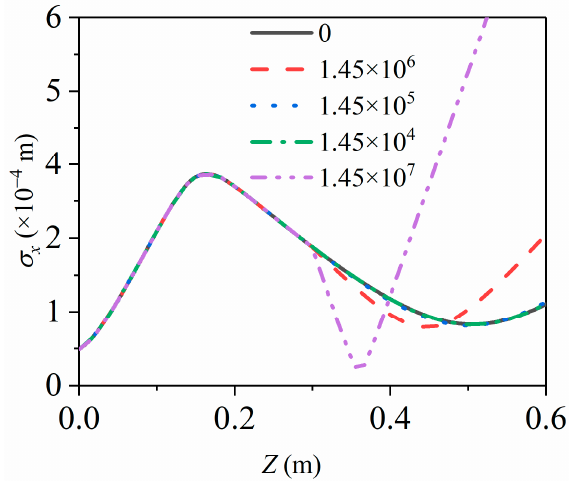
Figure 6. RMS radius σ x evolves during propagation at various longitudinal compression strengths, while the solid black line is 0, the red dashed line is 1.45 × 10 6 V/m, the blue dot is 1.45 × 10 5 V/m, the green dashed line is 1.45 × 10 4 V/m and the purple double-dotted line is 1.45 × 10 7 V/m.